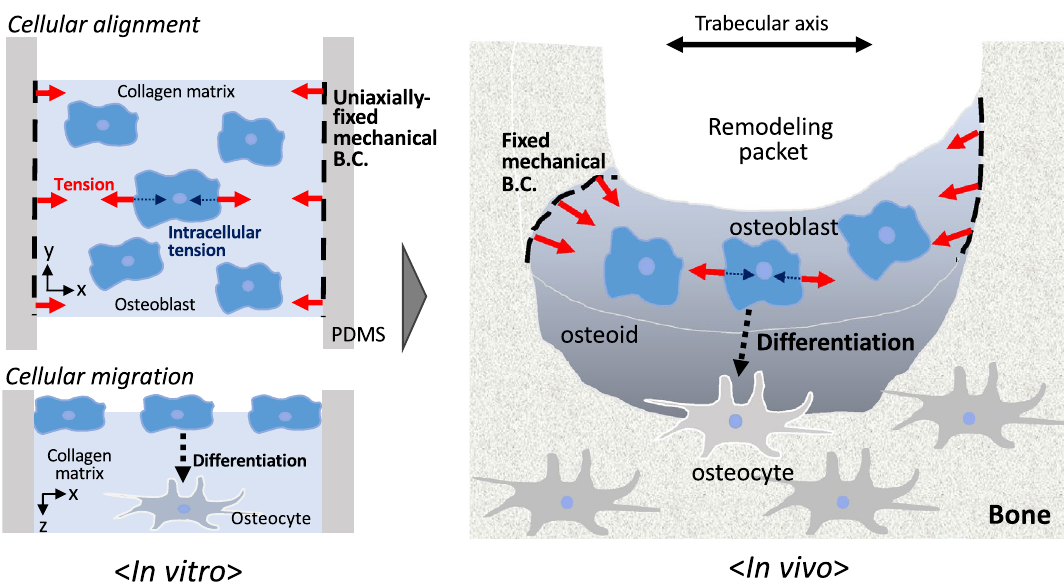
Figure 4. Schematic diagram illustrating the significance of intracellular tension and uniaxially-fixed boundary condition in the bone matrix to understand the formation process of in vivo osteocyte